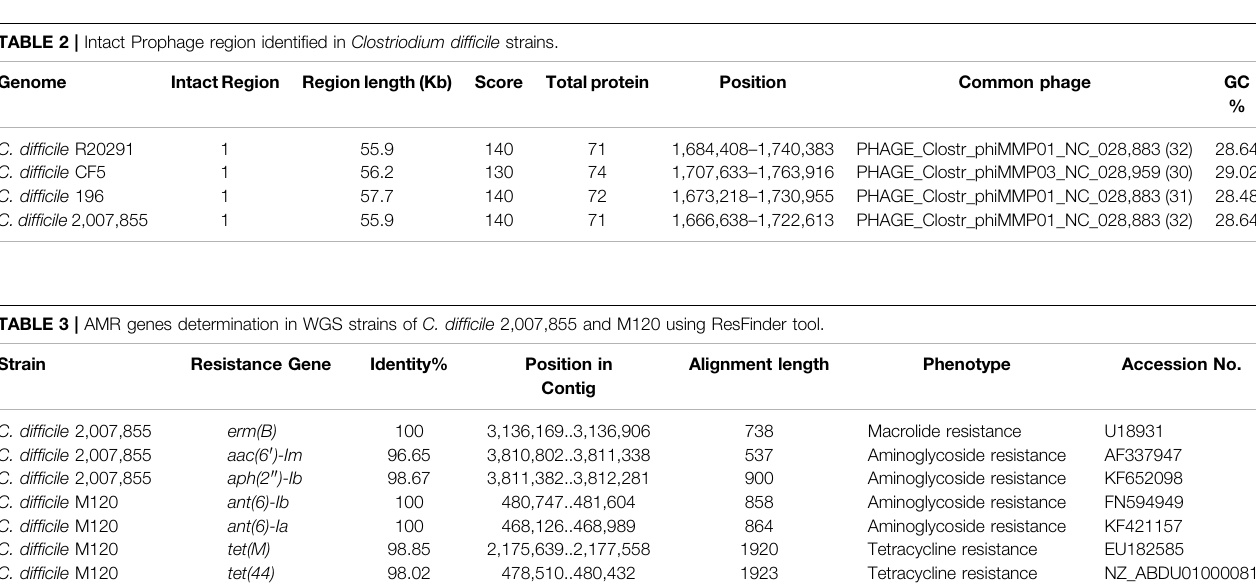
FIGURE 2 | Overview of Subsystem Category Distribution for six strains (A) C. dif fi cile strain CF5. (B) C. dif fi cile strain BR81 (C) C. dif fi cile strain R20291 (D) C. dif fi cile strain 196 (E) C. dif fi cile strain 2,007,855 (F) C. dif fi cile strain M120. Identi fi cation of Prophage and CRISPR-Cas9 systems.